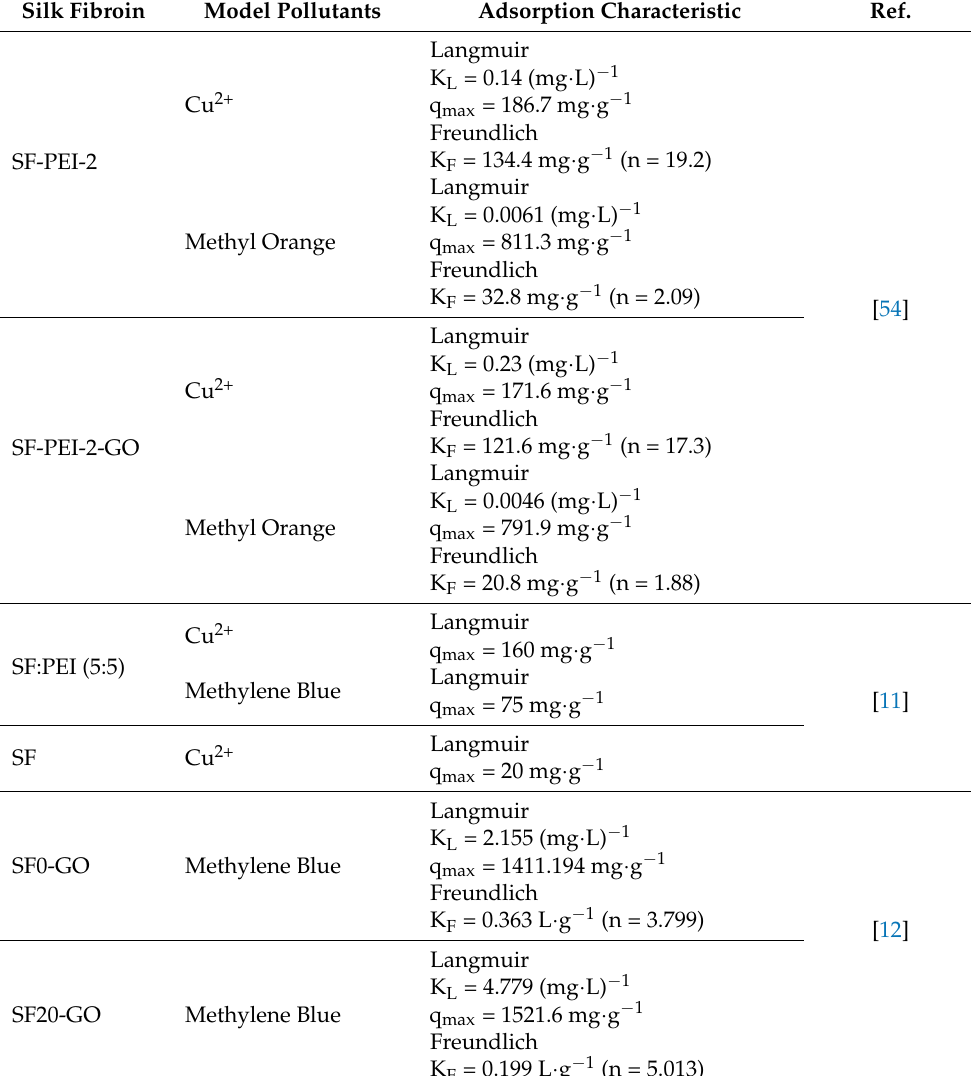
Table 4. Comparative results of SF-based biosorbent for dye and heavy metal adsorption. Silk